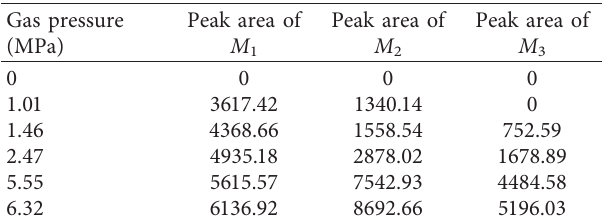
Figure 11: Relationship between T pressure. Table 2: Relationship between the quantity of polymorphic methane and gas